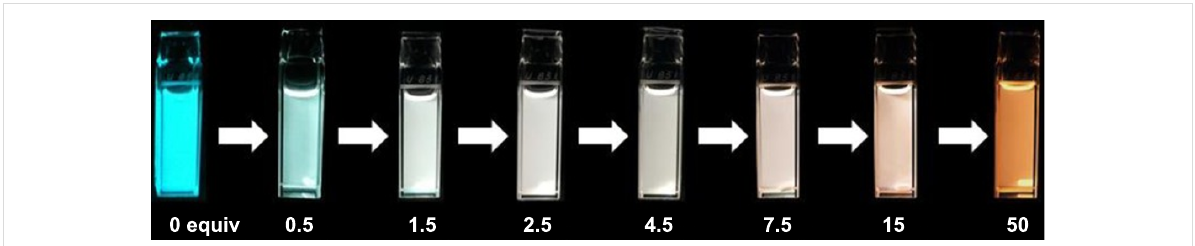
Figure 7: Photos of a solution of compound 12 and B(C 6 F 5 ) 3 at different ratios in toluene under a 365 nm UV lamp. Figure 7 was reproduced from [38] (© 2016 K. Yamaguchi et al., published by Wiley-VCH Verlag GmbH & Co. KGaA, distributed under the terms of the Creative Commons